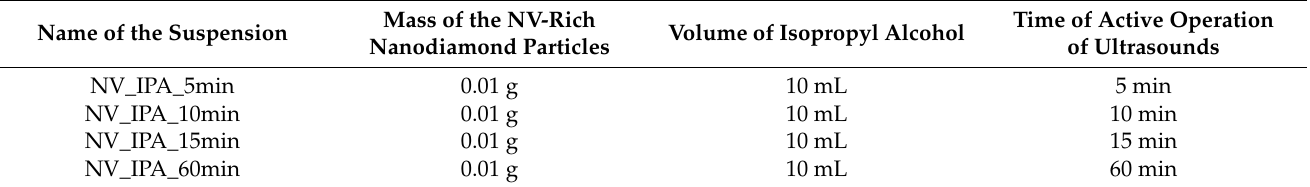
Table 1. Parameters of the preparation of isopropanol-based suspensions subjected to various durations of ultrasonic treatment. Time of Active Operation Mass of the NV-Rich Volume of Isopropyl Alcohol Name of the Suspension of Ultrasounds